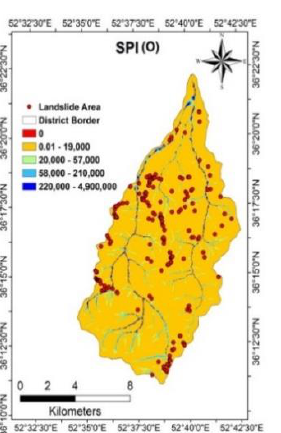
Figure 1. (a) Study area, (b) Land use map, (c) Geology map, (d) Altitude, (e) Slope, (f) Aspect, (g) Topographic Wetness Index (TWI), (h) Terrain Roughness Index (TRI), (i) Distance to Fault, (j) Distance to Stream, (k) Distance to Road, (l) Total Curvature, (m) Profile Curvature, (n) Plan Curvature, (o) Stream Power Index (SPI).